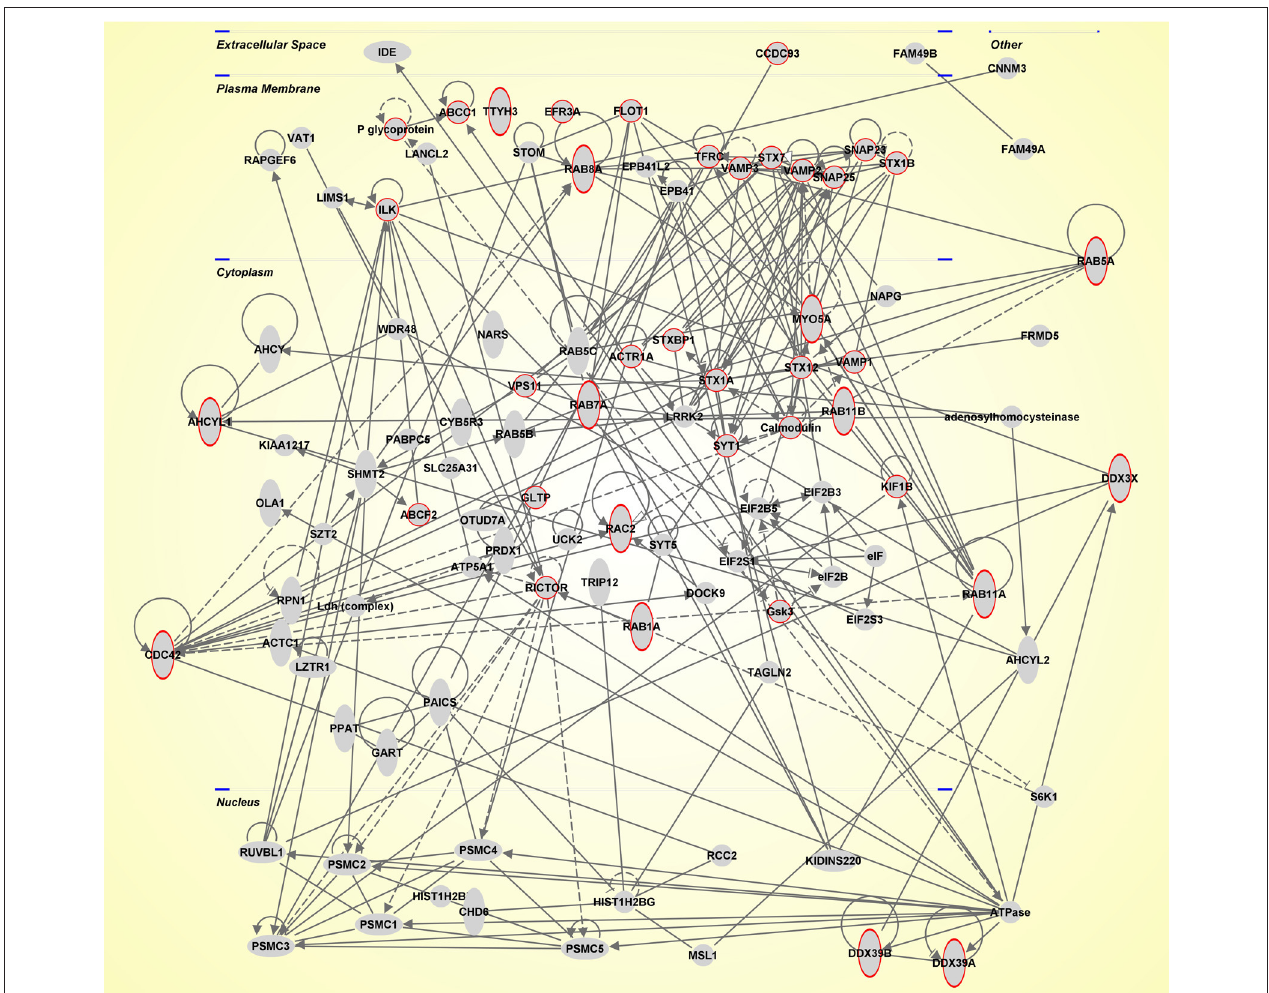
FIGURE 1 | Ingenuity Pathway Analysis. Network suggested by QIAGEN’s Ingenuity Pathway Analysis (IPA, QIAGEN Redwood City, USA. www.qiagen.com/ingenuity) for the molecules identified in EVs, by focusing on the SNC, that were present in databases. The network is depicted with the subcellular layout. Red circles highlight the top function linked with the network: “secretory pathway” ( p -value 3.4e − 14 ).